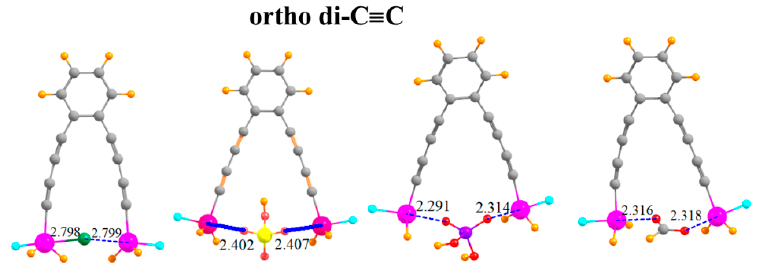
Figure 6. Complexes of Cl − , HSO 4 − , H 2 PO 4 − , and HCOO − with -C ≡ C-C ≡ C- extensions on ortho positions of phenyl ring.